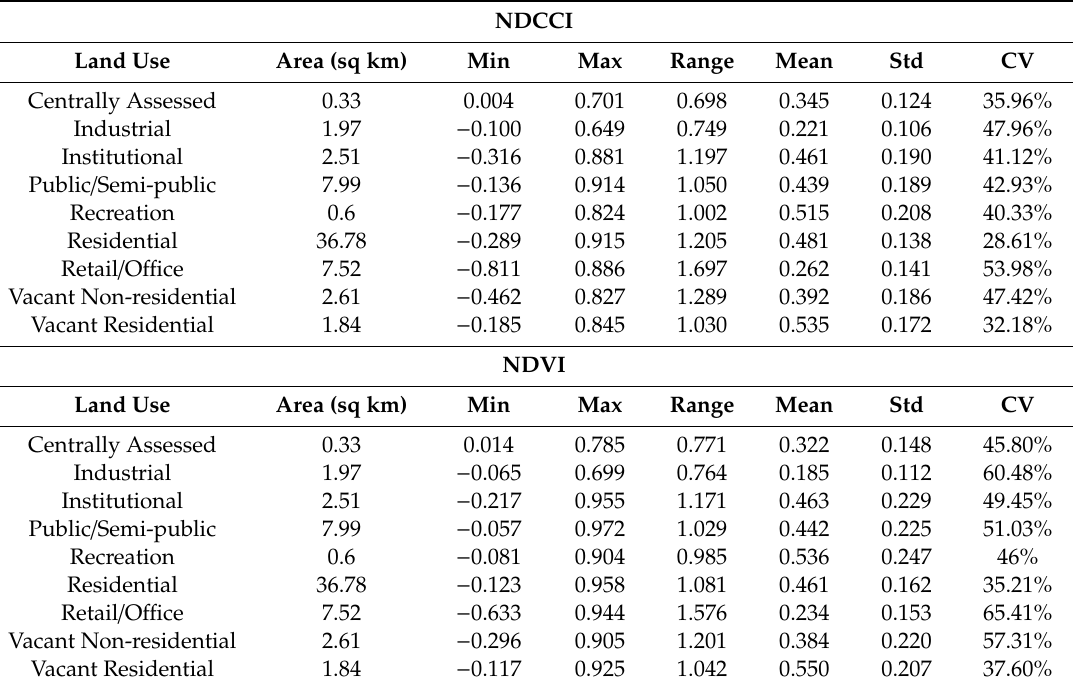
Table 7. Zonal statistics of 22 October 2016 NDCCI and NDVI, referencing FGDL